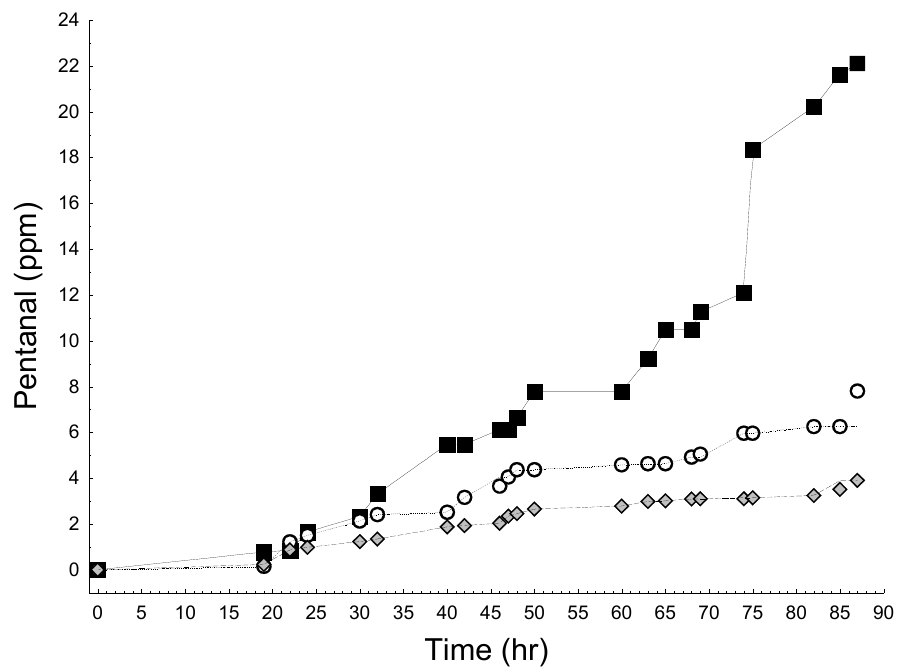
Figure 6. Antioxidant activity of BHT (100 ppm), and whole cranberry extract (WCE) in 25% sunflower o/w emulsions (pH 5.6) incubated at 50 °C for 90 h. Bars represent % inhibition ± SD of conjugated dienes ( □ ), hexanal ( ■ ) and pentanal ( ▒ ), as calculated using area under the